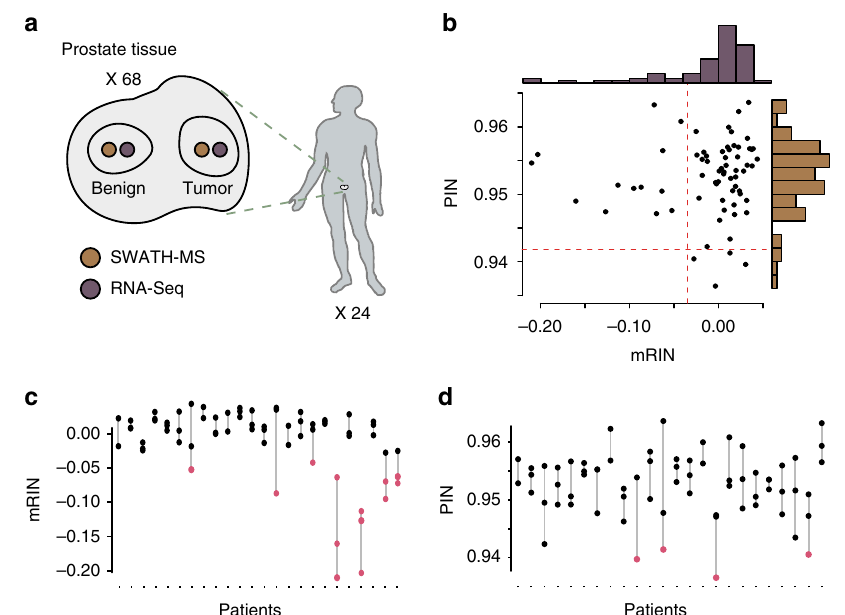
Fig. 3 Comparisons of mRNA and protein degradation in the clinical cohort. a The experimental design. The human fi gure is a modi fi ed version of a drawing from Buljan et al. 31 , published under a CC BY 3.0 license. b Comparison of the degrees of degradation at mRNA and protein levels, measured by mRIN and PIN respectively ( n = 68). c Patient-speci fi c mRNA degradation patterns observed. Samples with signi fi cant mRNA degradation are marked in red. d Patient-speci fi c protein degradation patterns observed. Samples with signi fi cant protein degradation are marked in